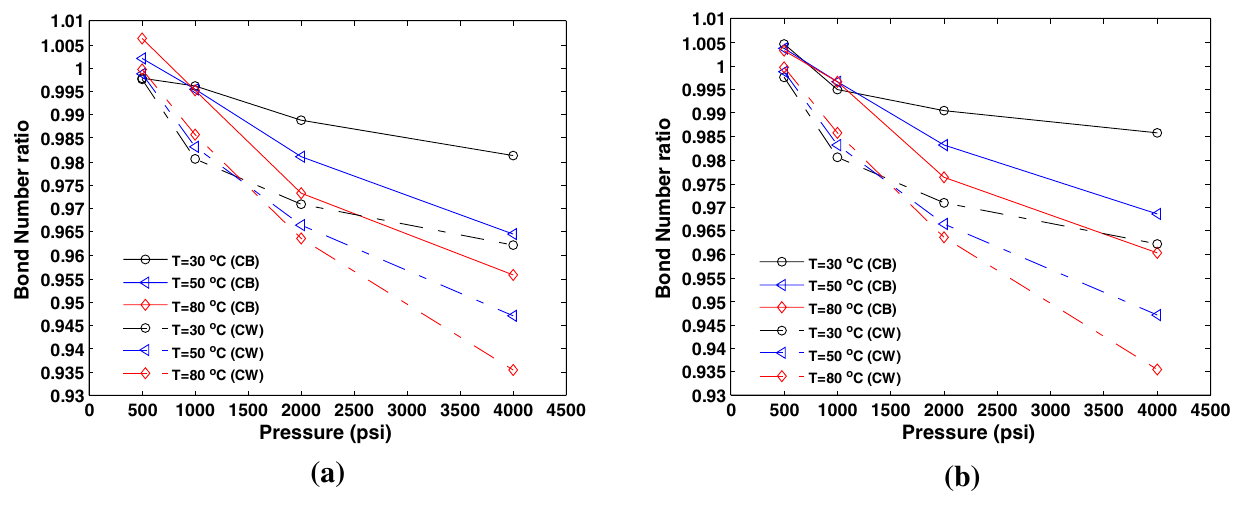
Fig. 8 Comparison of Bond number ratio in the presence and absence of a Na